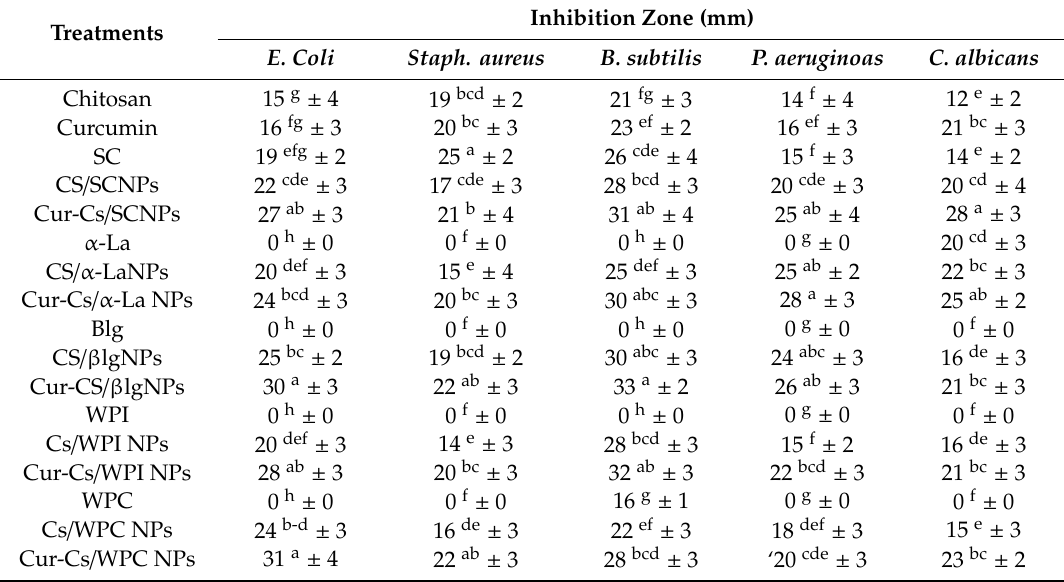
Antimicrobial activity of native proteins, chitosan–milk protein nanocomposite and curcumin-loaded milk protein